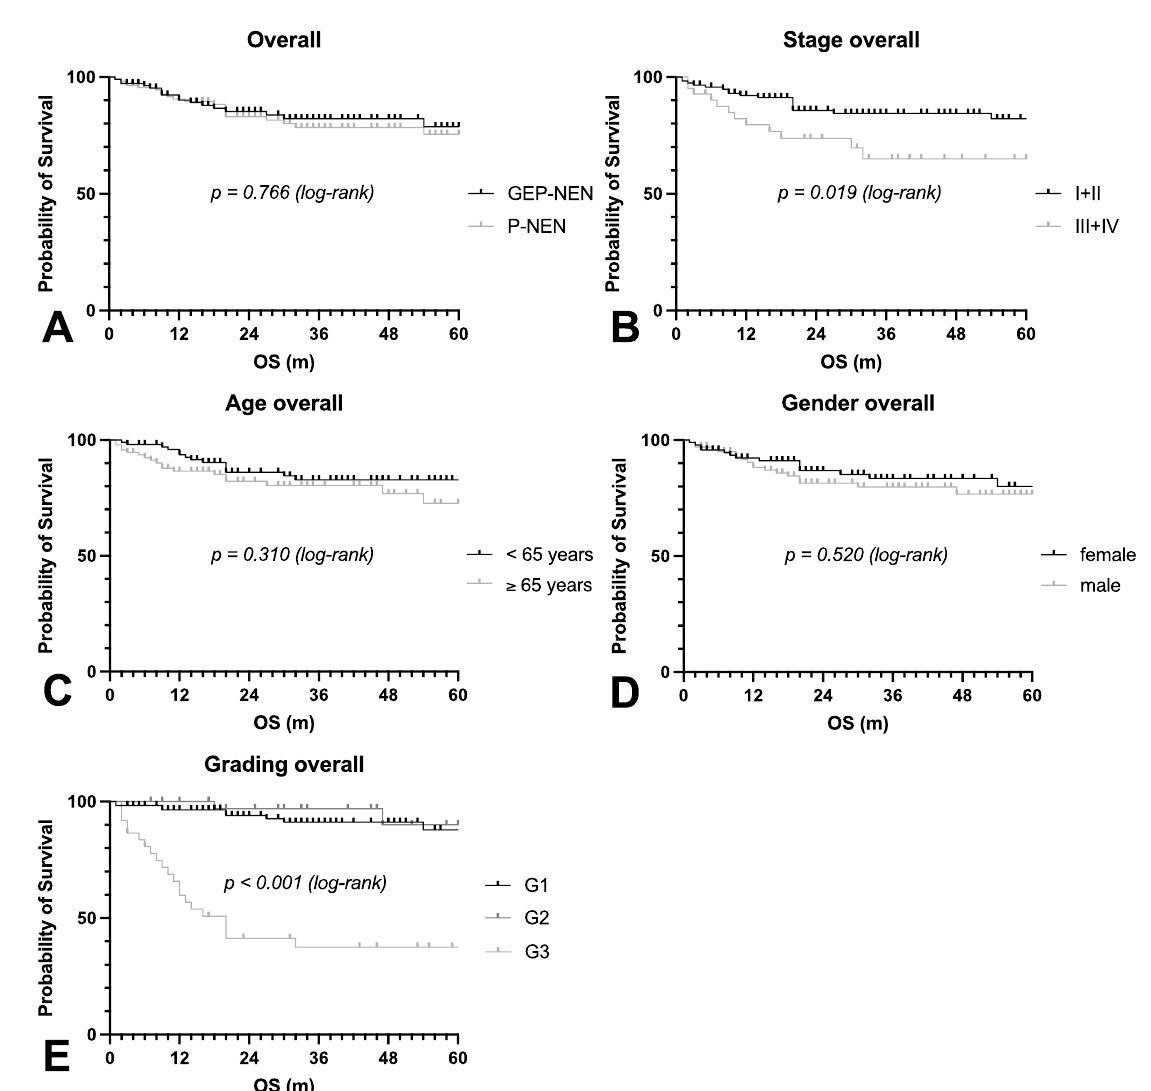
Figure 1. Overall survival based on clinical characteristics. The overall survival (OS) of all enrolled patients with GEP-NEN or P-NEN was calculated ( A ). Additionally, the OS with respect to the UICC stage ( B ), age ( C ), gender ( D ), and grading ( E ) was calculated. GEP: gastroenteropancreatic, NEN: neuroendocrine neoplasia, OS: overall survival, P: pulmonary. Two cases with carcinoma morphology and p53 overexpression showed strong ex- pression of Chromogranin A and SSTR2A. One other tumor had a carcinoid morphology but overexpression of p53, a loss of SSTR2A, and a high mitotic count (28/10 HPF). To our understanding, such cases currently cannot be assigned to one of the two